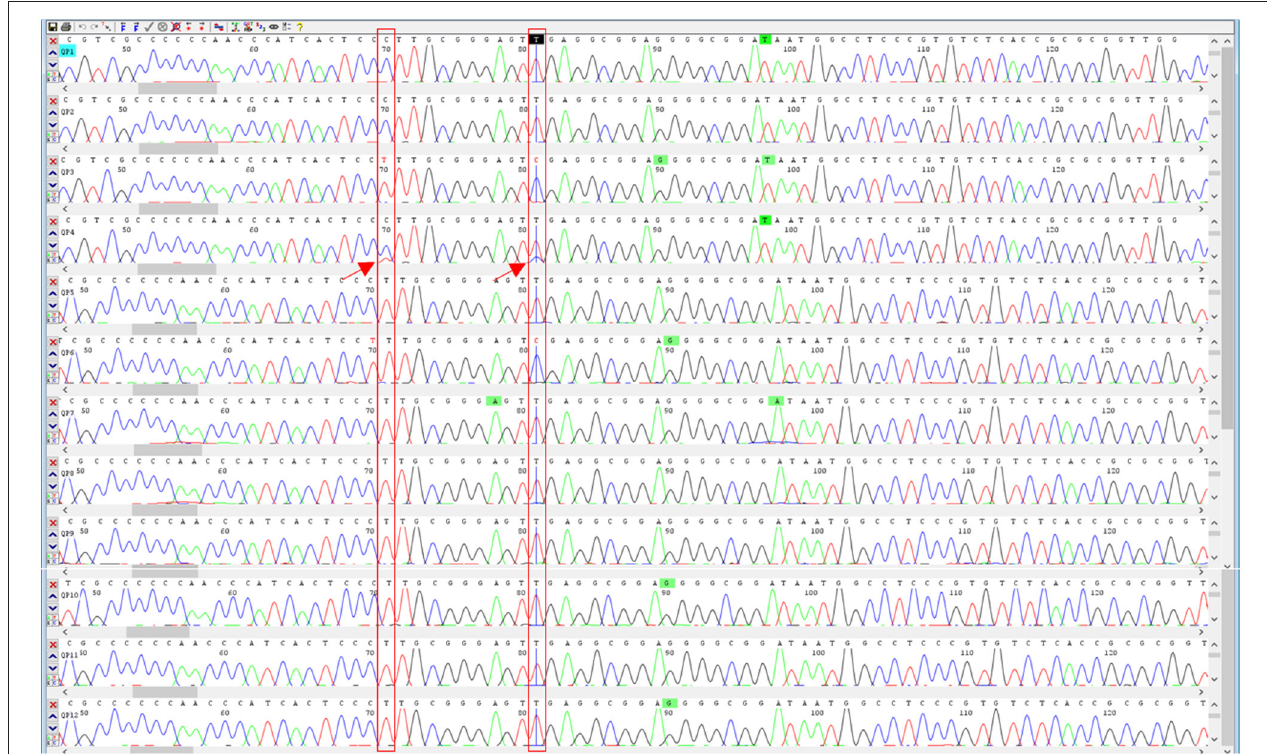
FIGURE 2 | Sequencing peak profiles of the 12 samples of Qipi pill. The double peaks marked by red arrows indicated adulterated P. quinquefolius in the corresponding CPM products.